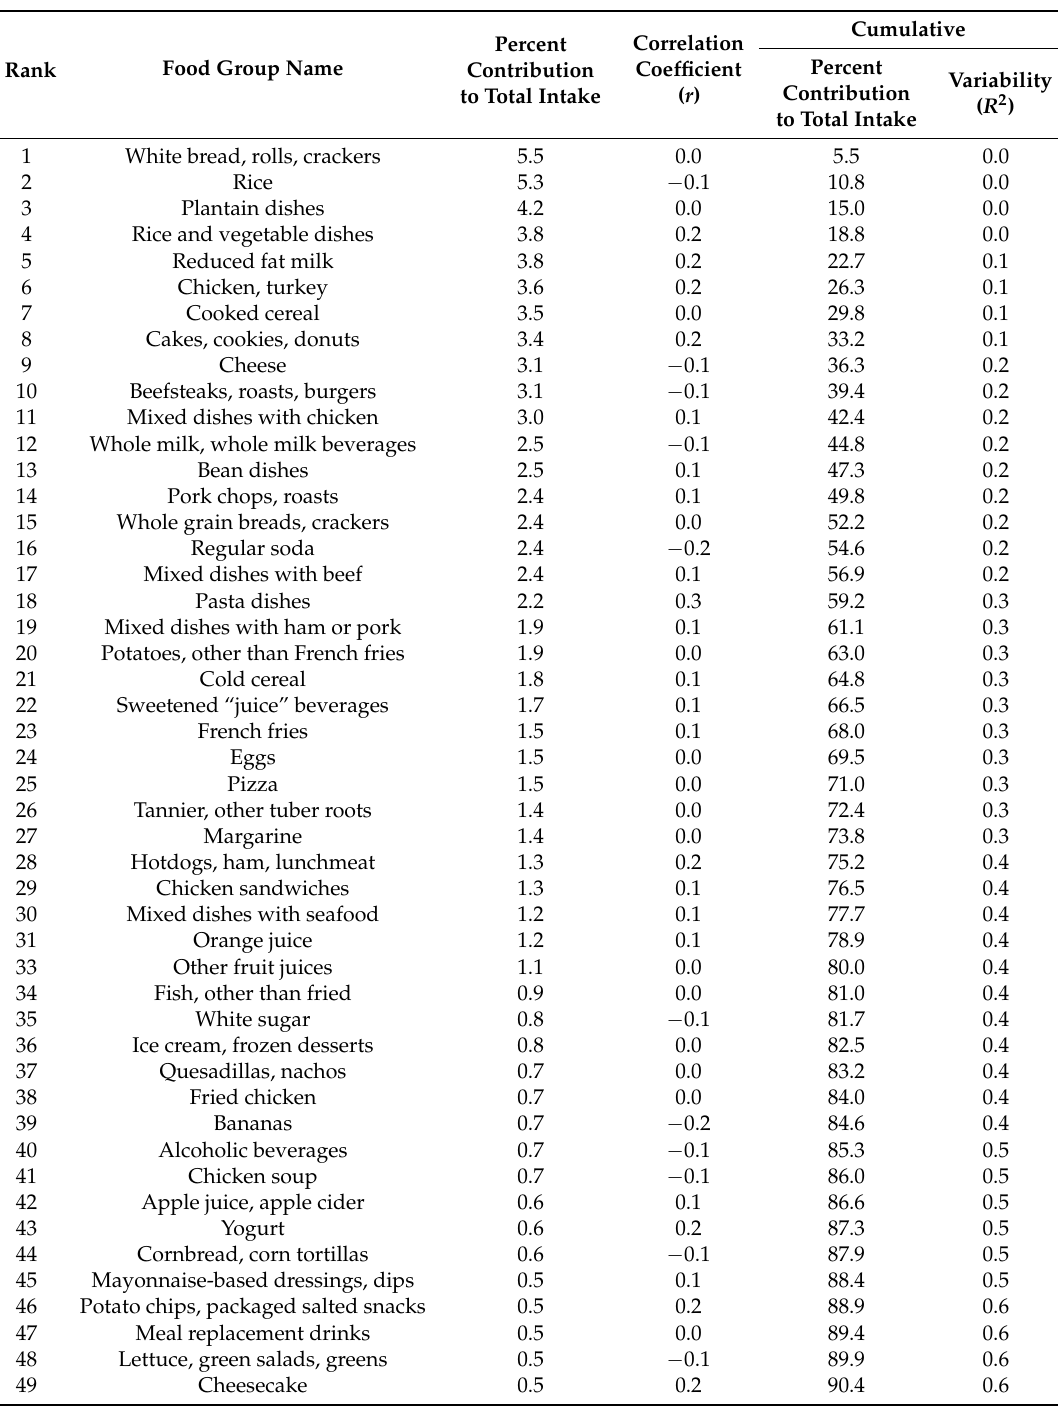
Table 1. Foods contributing to energy (kcal) intake, Puerto Rican